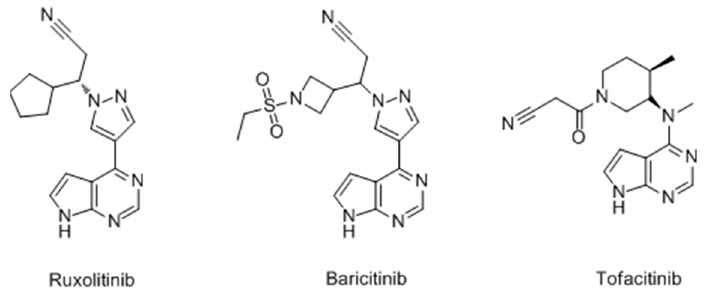
Figure 37. Structure of JAK inhibitors.